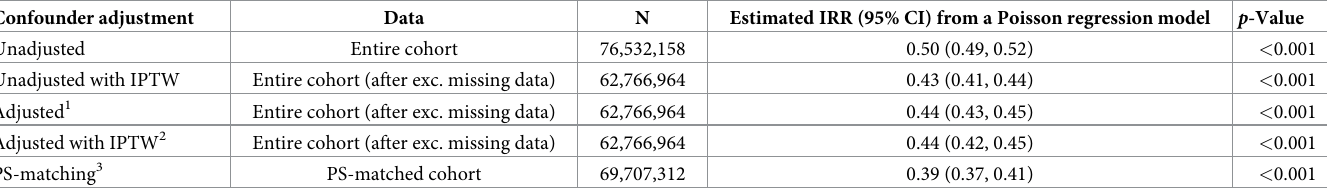
Table 3. Suicide IRR for BFP participation in the matched and original cohorts from 2004–2015.